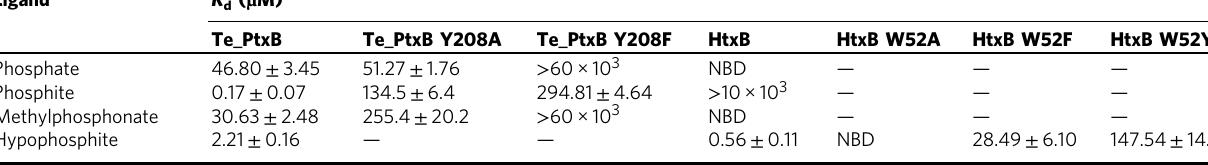
Table 3 Microscale thermophoresis determined dissociation constants ( K d ) of Te_PtxB and HtxB binding pocket mutants Ligand